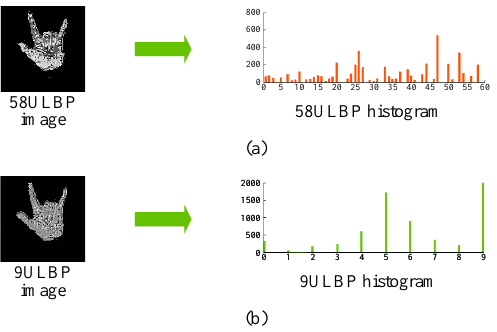
Figure 7. ( a ) 58ULBP image and its histogram. ( b ) 9ULBP image and its histogram.